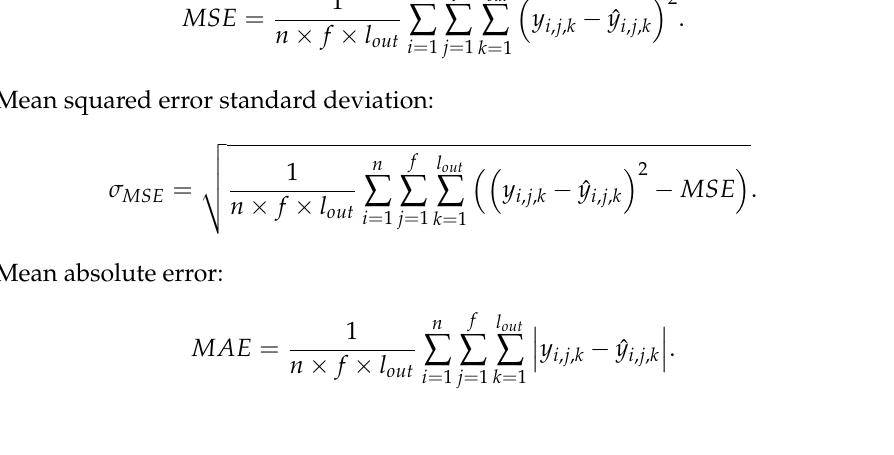
Table 1. Hyper-parameter optimisation for the LSTM network, CNN, and FCN. Hyper-Parameter learning LSTM